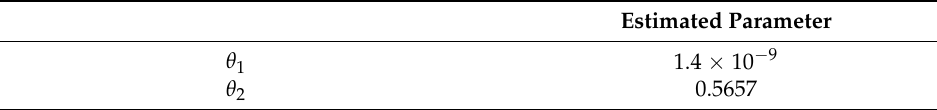
Table 9. DCC-GARCH estimated parameters